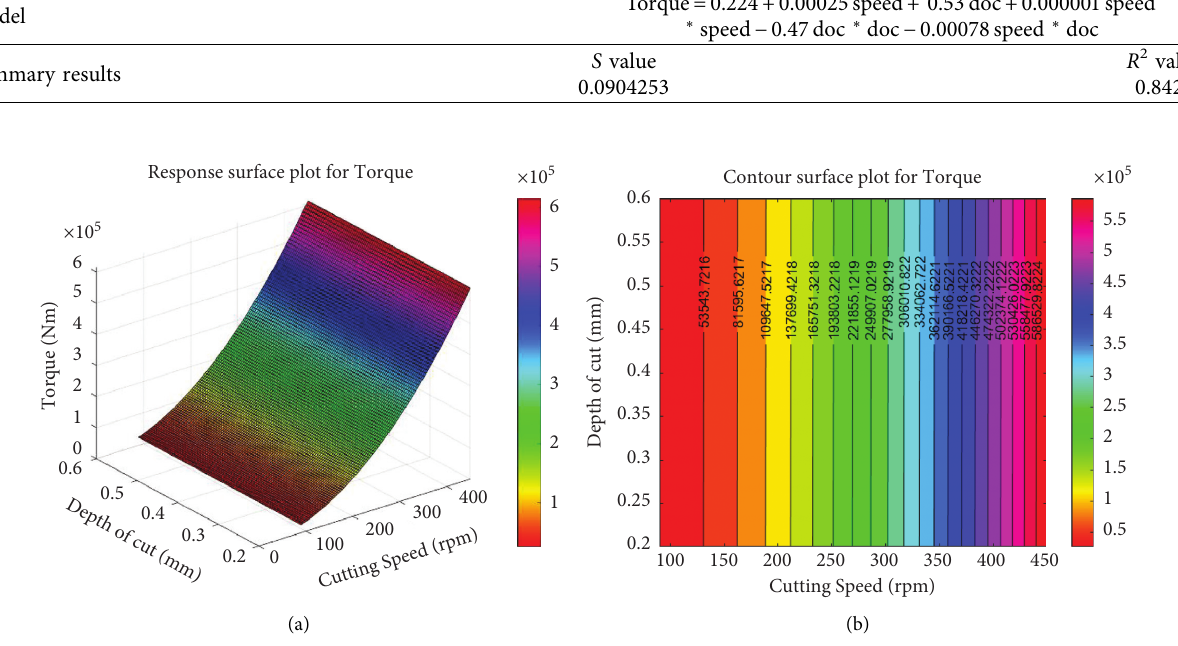
Figure 7: (a)Response surface graph for torque (cutting speed vs. depth of cut). (b)Contour surface plot for torque (cutting speed vs. depth of